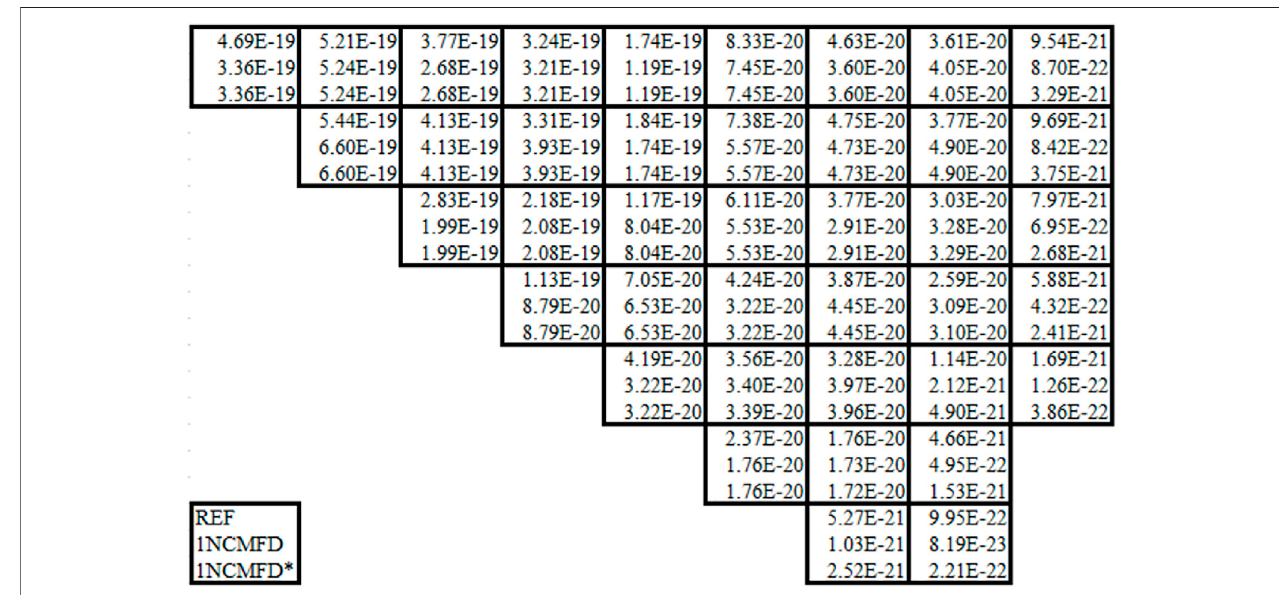
FIGURE 11 | One-node CMFD – based fast group numerical adjoint fl ux for the KWU 2D problem. The adjusted result is denoted with an asterisk (*).